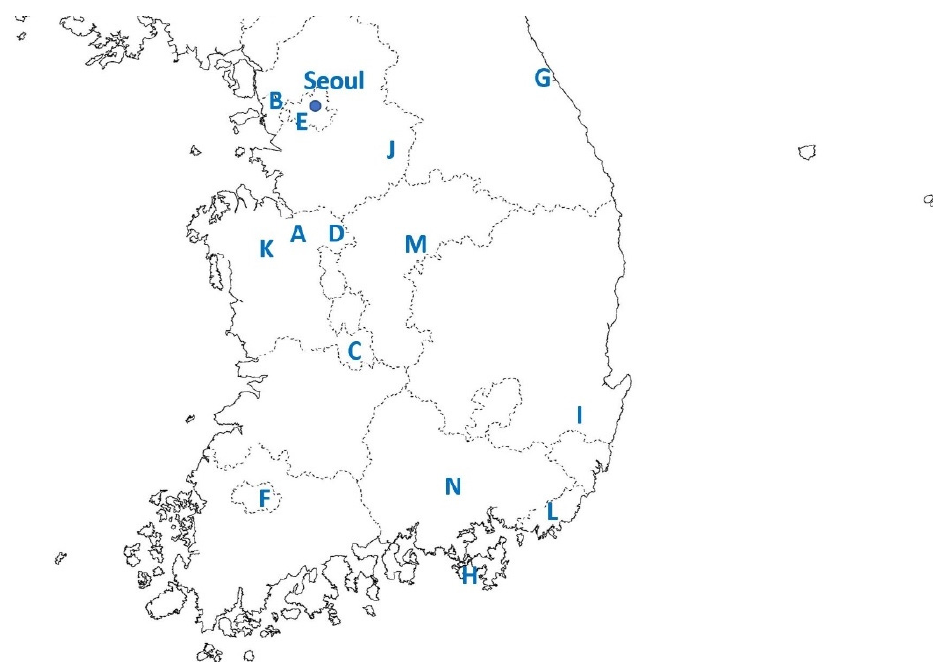
Figure 2. Locations of the Fourteen National Shrines (scattered all over the country).